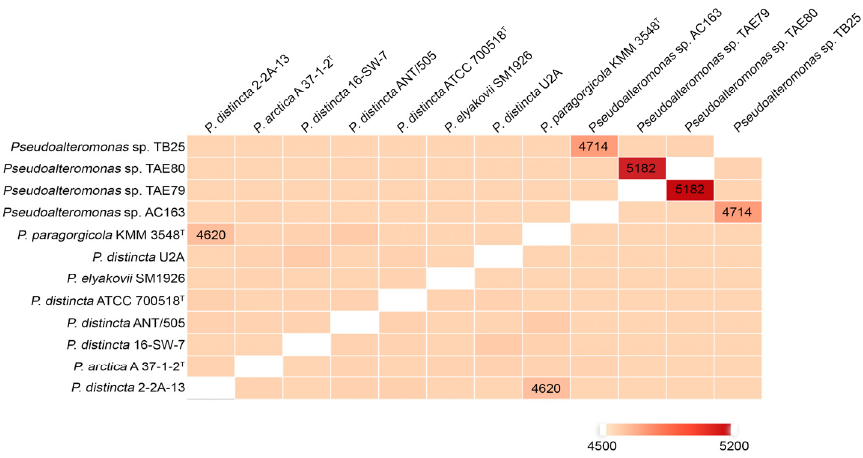
Figure 3. Similarity matrix for pairwise genome comparisons plotted by OrthoVenn2: the heatmap shows the ortholog clusters between any pair of genomes.